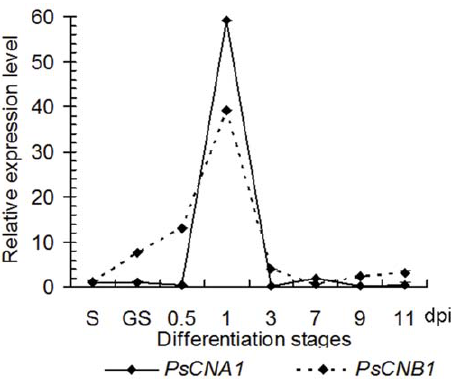
Figure 3. Transcript levels of PsCNA1 and PsCNB1 during Pst differentiation stages. RNA samples were isolated from leaves of wheat cultivar Suwon 11 inoculated with Pst race CYR31 at the indicated time points. Expression levels of PsCNA1/PsCNB1 were estimated by the DD Ct method with the elongation factor gene of Pst as endogenous reference for normalization. S: urediospore, GS: germinated urediospore, dpi: days post inoculation.